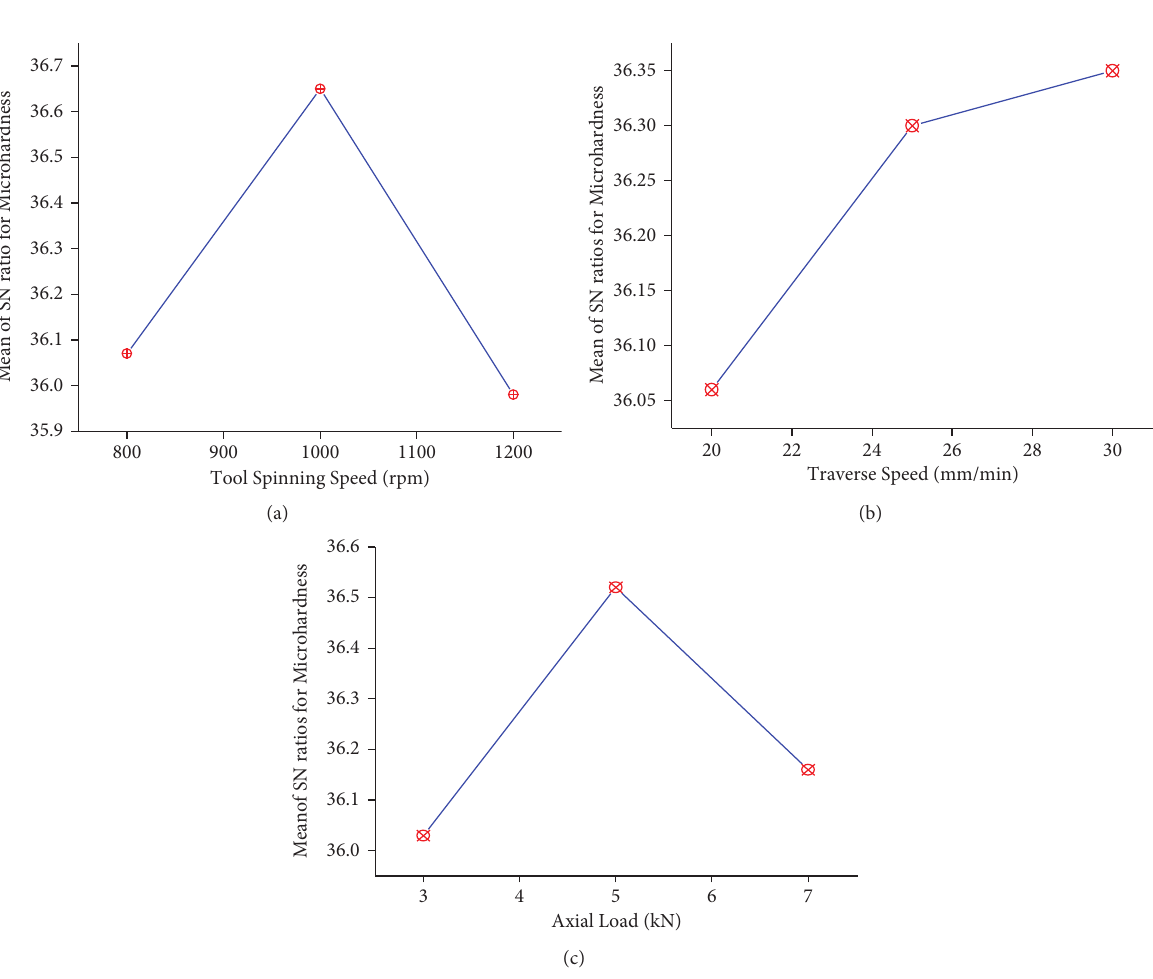
Figure 6: Mean of S/N ratios for (a) microhardness versus tool spinning speed, (b) microhardness versus traverse speed, and (c) microhardness versus axial load.